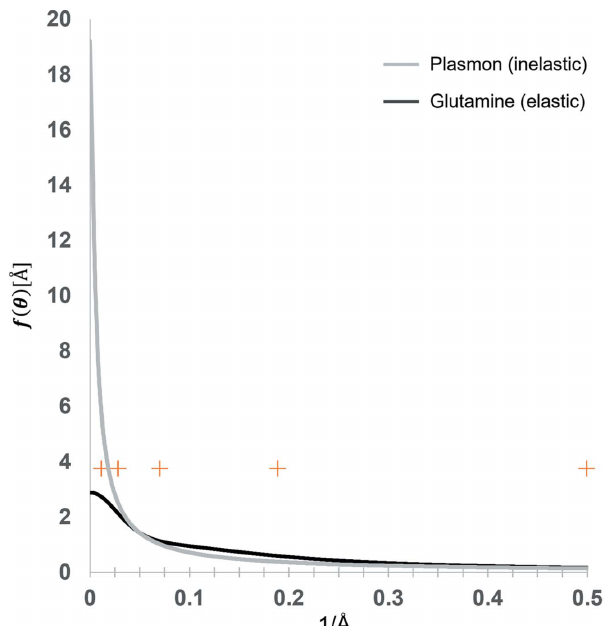
Figure 1 Elastic scattering factor for a glutamine molecule (black line) versus the inelastic scattering factor for a plasmon pseudo-particle (grey line). Orange markers indicate the right edge of bins compromising 20% of the band-limited scattering probability for the inelastic plasmon scattering factor as calculated from the squared norm of the scattering